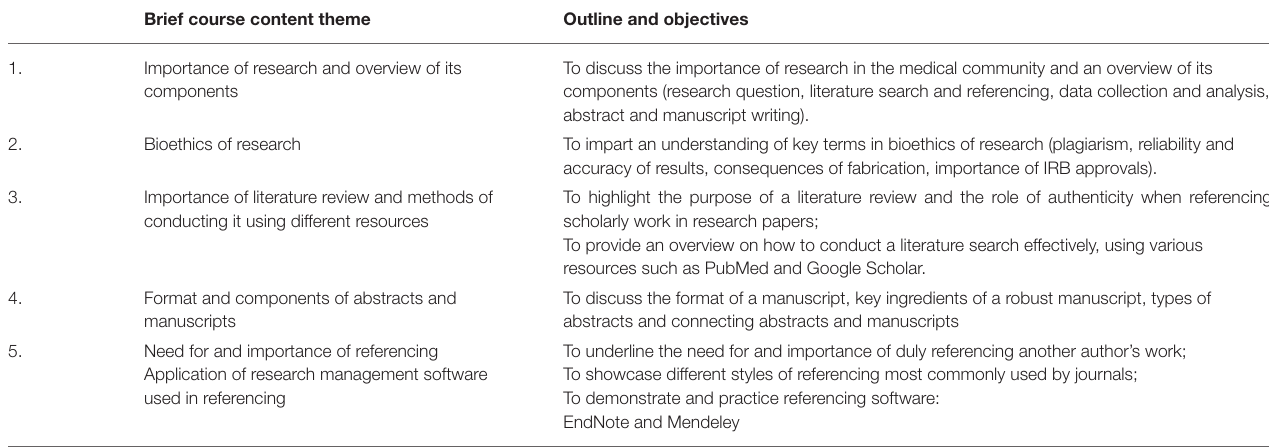
TABLE 1 | Summary of the key objectives and format of instruction and assessment employed in the research skills development courses.